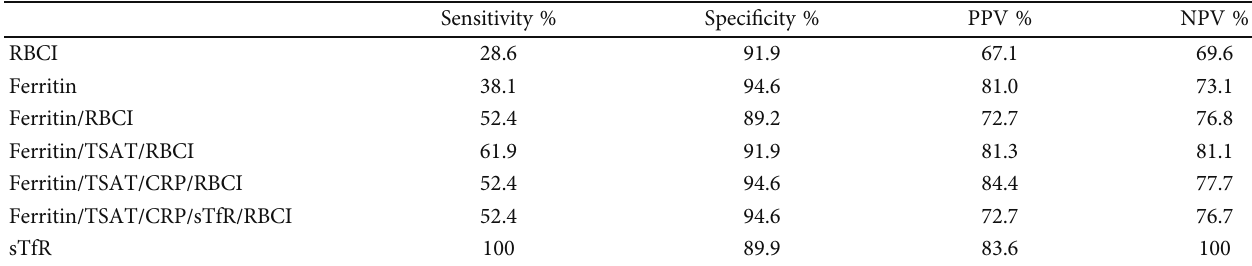
Table 4: Sensitivity, speci fi city, and predictive values of sTfR and standard parameters of iron status alone and in combination for the diagnosis of IDA or ACD/IDA ( N = 21 ) in patients with CRP > median = 24 : 1mg/l ( N = 58 ).